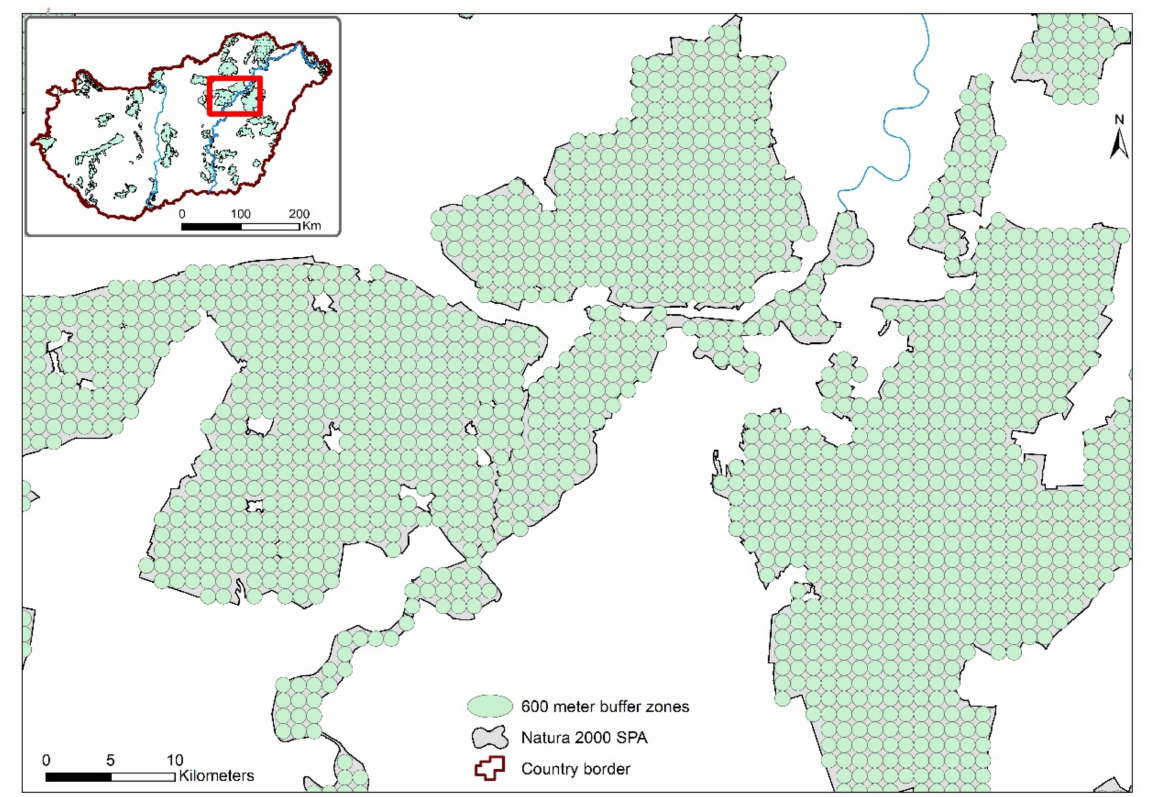
Figure 3. Example the spatial distribution of the 600-m buffer zones inside a Natura 200 Spa protected area of